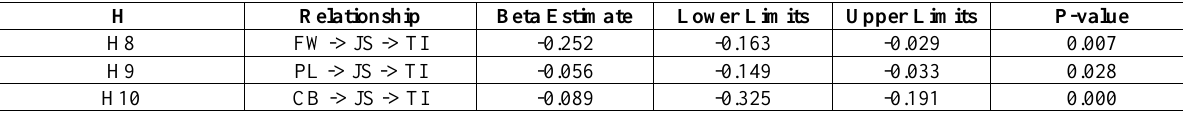
Table 4. Hypothesis Testing for Indirect